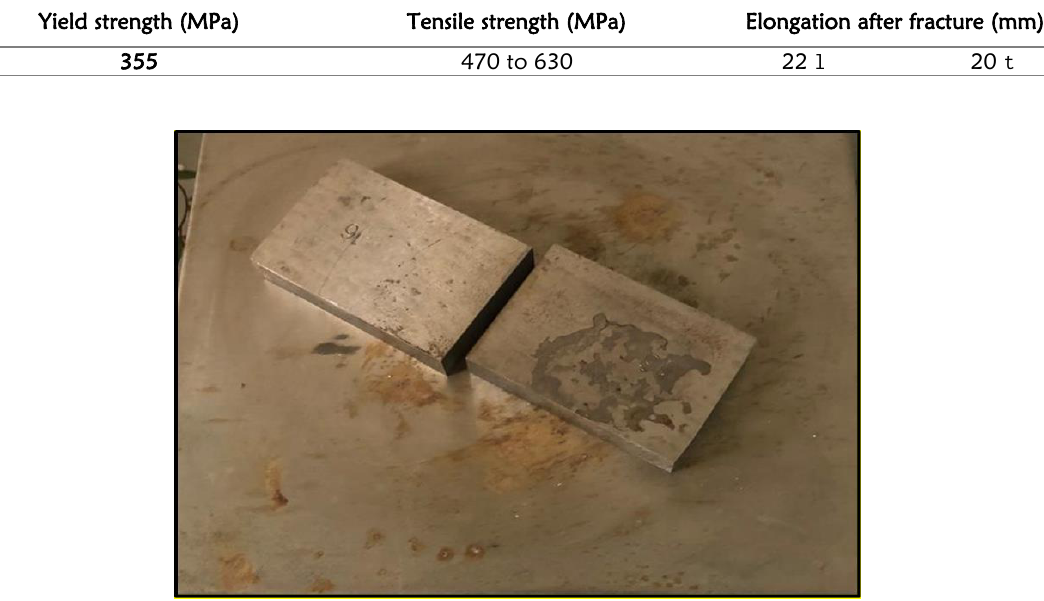
Figure 1: Photograph of the carbon steel